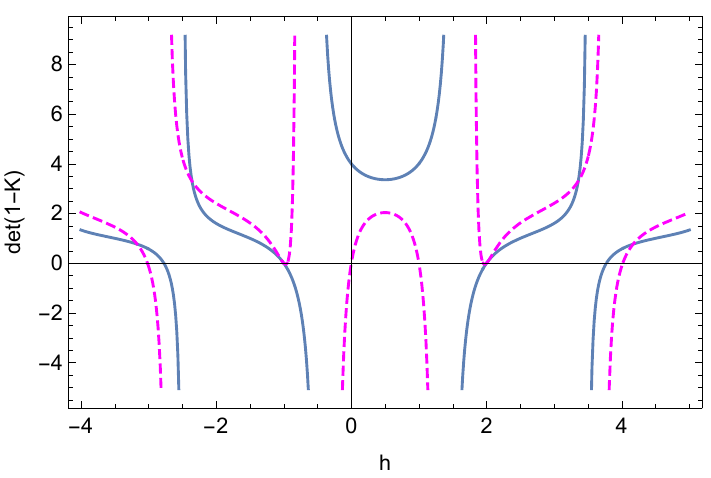
Figure 4 . Plot of det( 1 K ) as a function of the left scale dimension h with (cid:22) h = 0. The dashed (cid:0) magenta plot corresponds to (cid:1) = 1 = 4 and s = 1 = 2, and the blue plot to (cid:1) = s = 1 = 4. with (cid:1) = (cid:1) s . The action of K (cid:6) on the four point functions can be computed with ab (cid:6) (cid:6)